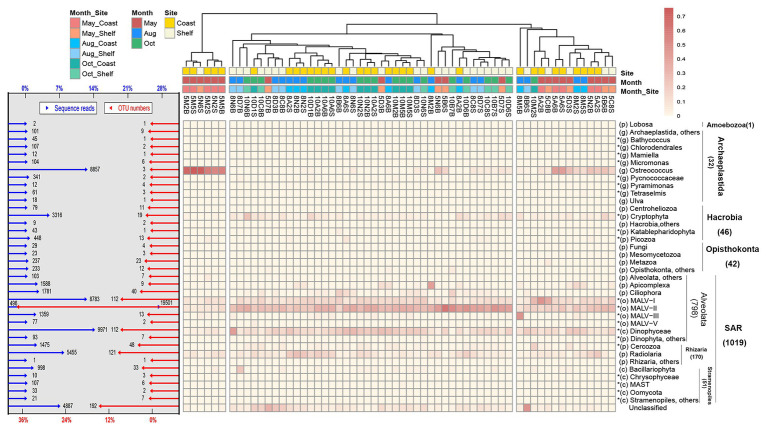
The distribution and relative abundance of different taxonomic lineages in the entire protist community in 60 samples. The OTUs were defined at 97% sequence similarity threshold. Heatmap showed the relative abundance of the 37 lineages which were classified into seven supergroups within each sample; each of the lineages that contained more than 10 sequence reads within the entire dataset was individually presented, whereas the rare lineages (fewer than 10 sequence reads) and the undetermined lineages (sequence similarity >80%) merged as “others.” Sequence reads are “unclassified” when sequence similarity to a reference sequence is <80%. The OTU numbers are given in parentheses for each supergroup. The rank classification of each lineage is listed before with lowercase in bracket (“p” for phylum, “c” for class, “o” for order, and “g” for genus). An asterisk in front of the taxon indicates the lineages belonging to flagellates. Bar graphs in the left showed the relative abundance of sequence reads (species abundance) and OTU numbers (species richness) in the 37 branching lineages within the entire dataset (metacommunity including 60 local communities). Dendrogram on the top showed the clustering for 60 samples based on Bray-Curtis similarity. The color codes at the branch end were based on months, habitats, and both of them.